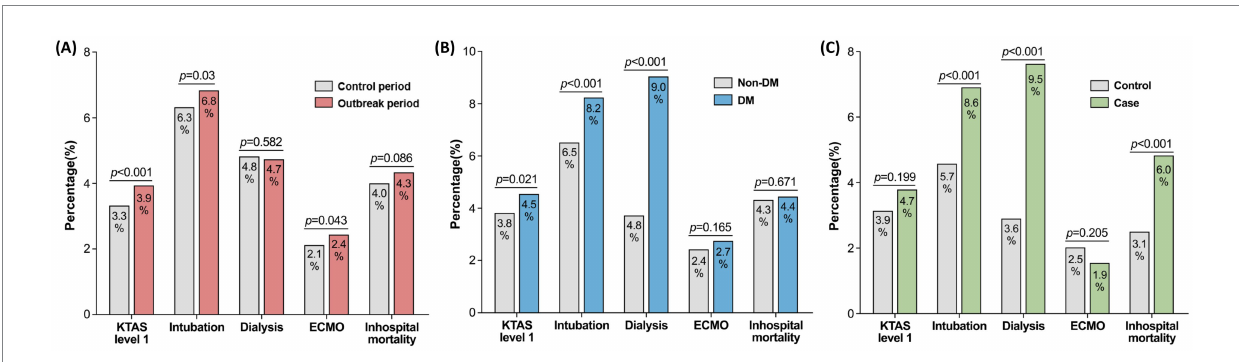
FIGURE 3 Differences in clinical outcomes in patients with AMI (A) between the outbreak and control periods and (B) according to the presence/absence of comorbid DM. (C) shows the comparison between patients with DM and either CKD, heart failure, or age ≥ 80 years (case) and those without DM, CKD, heart failure and age < 80 years (control). Two-sample tests for equality of proportion were performed to compare the rates. AMI, acute myocardial infection; DM, diabetes